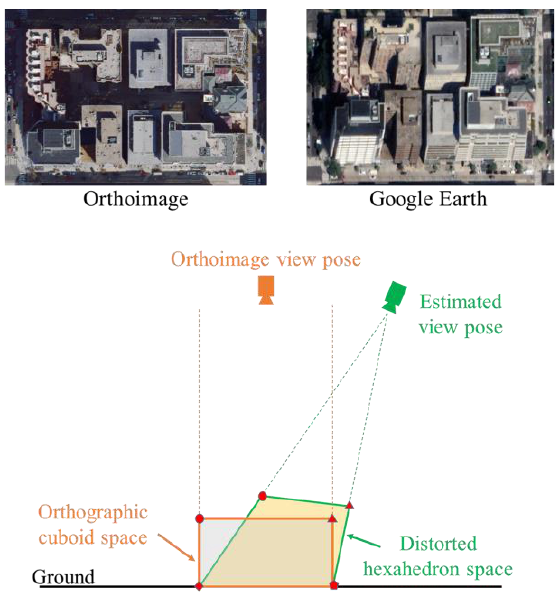
Figure 3 . 3D reconstruction result of MVS (Top: input GE image and disparity map, bottom: point cloud). The point cloud shows that the high elevation structure is slanted.